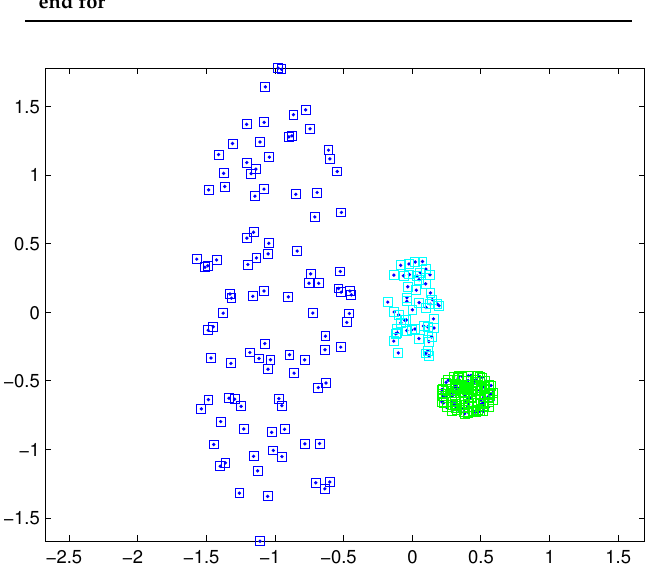
Figure 4. Partition by SNNSP for a certain similarity